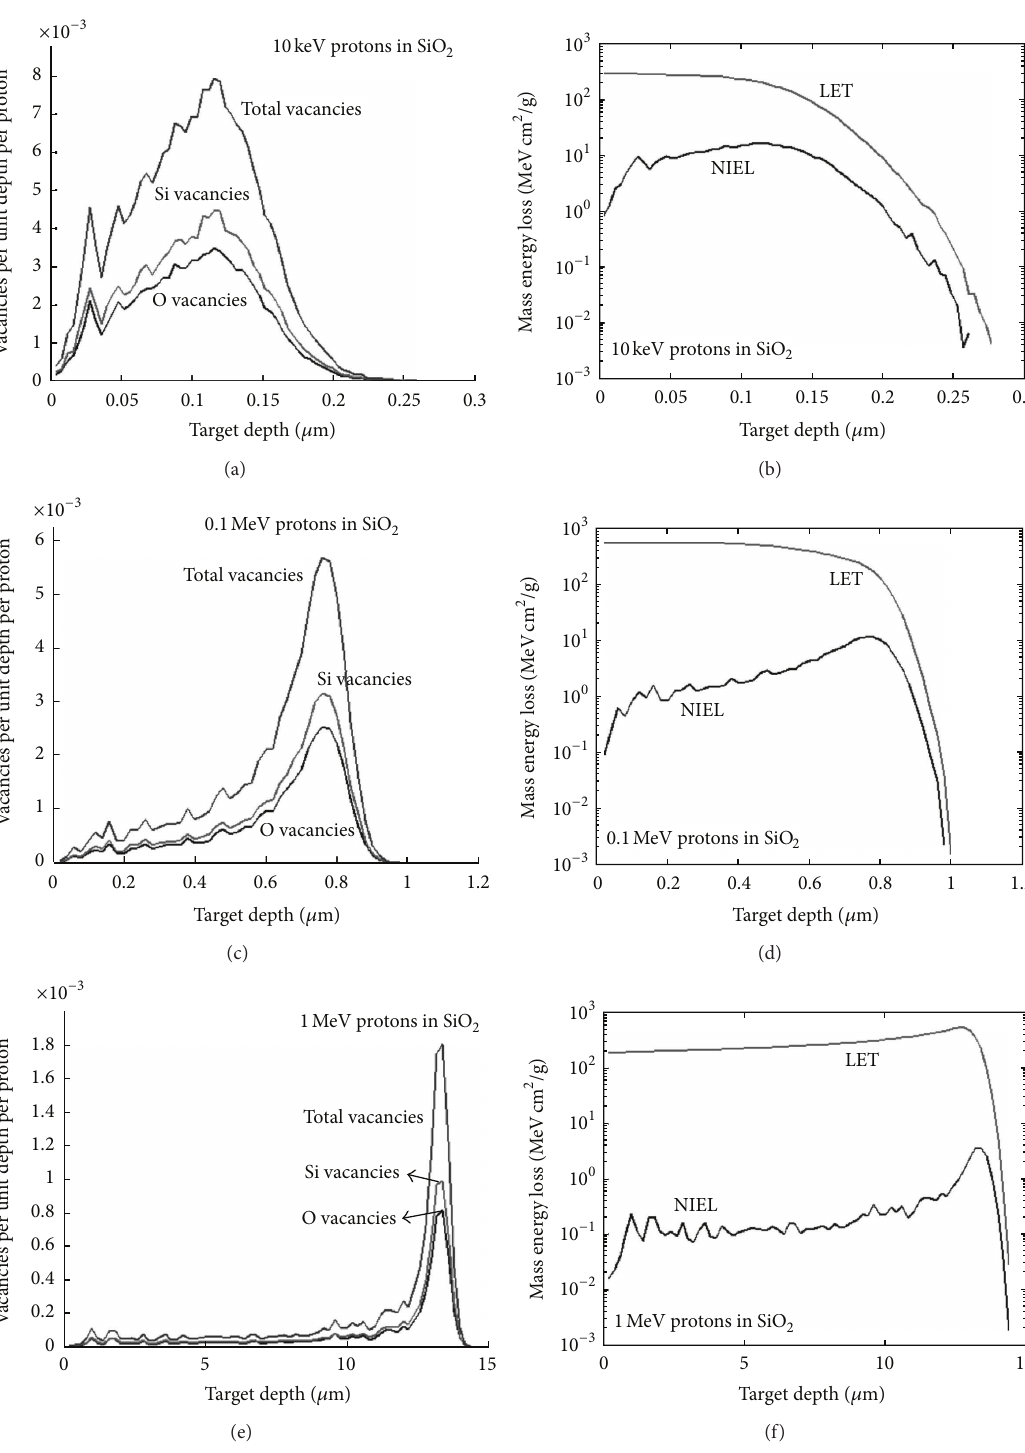
Figure 1: Plots of vacancy concentrations and mass energy losses (LET and NIEL divided by material density) along the depth of a silicon dioxide (SiO 2 ) insulating film. Results were obtained from simulations of 10 4 proton histories, which included subcascades of recoiling